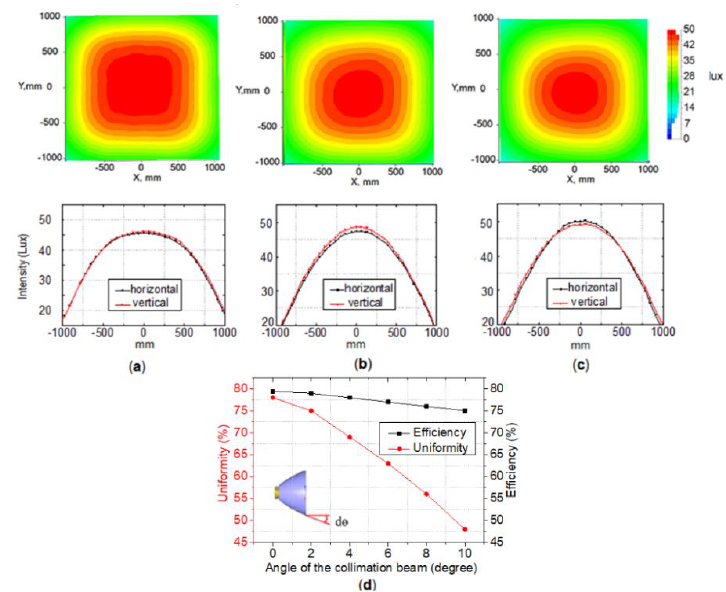
Figure 11. Light distribution on a receiver with ( a ) d θ = 2 ◦ ; ( b ) d θ = 4 ◦ ; and ( c ) d θ = 6 ◦ . ( d ) E ffi ciency and uniformity depend on the angle of the collimated